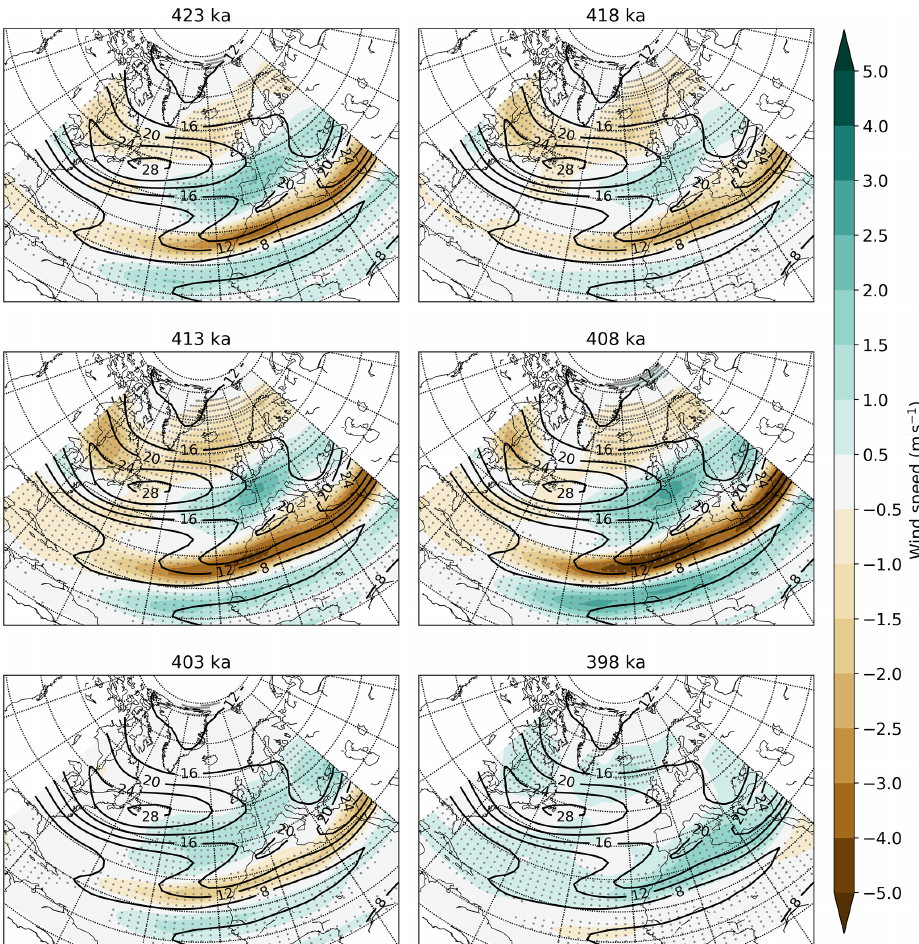
Figure 6. Mean JJA wind anomalies at 300hPa across the MIS-11 simulations (colors) and climatological 300hPa wind velocities from the piCtrl simulation (black contours). Anomalies significant at the 95% level via t testing are stippled. Evident reductions in mean winds across both the typical subtropical jet location ( ∼ 25–35 ◦ N) and the typical polar jet location ( ∼ 50–70 ◦ N) are present in most time slices, along with increases in mean winds across the eastern midlatitude North Atlantic and western